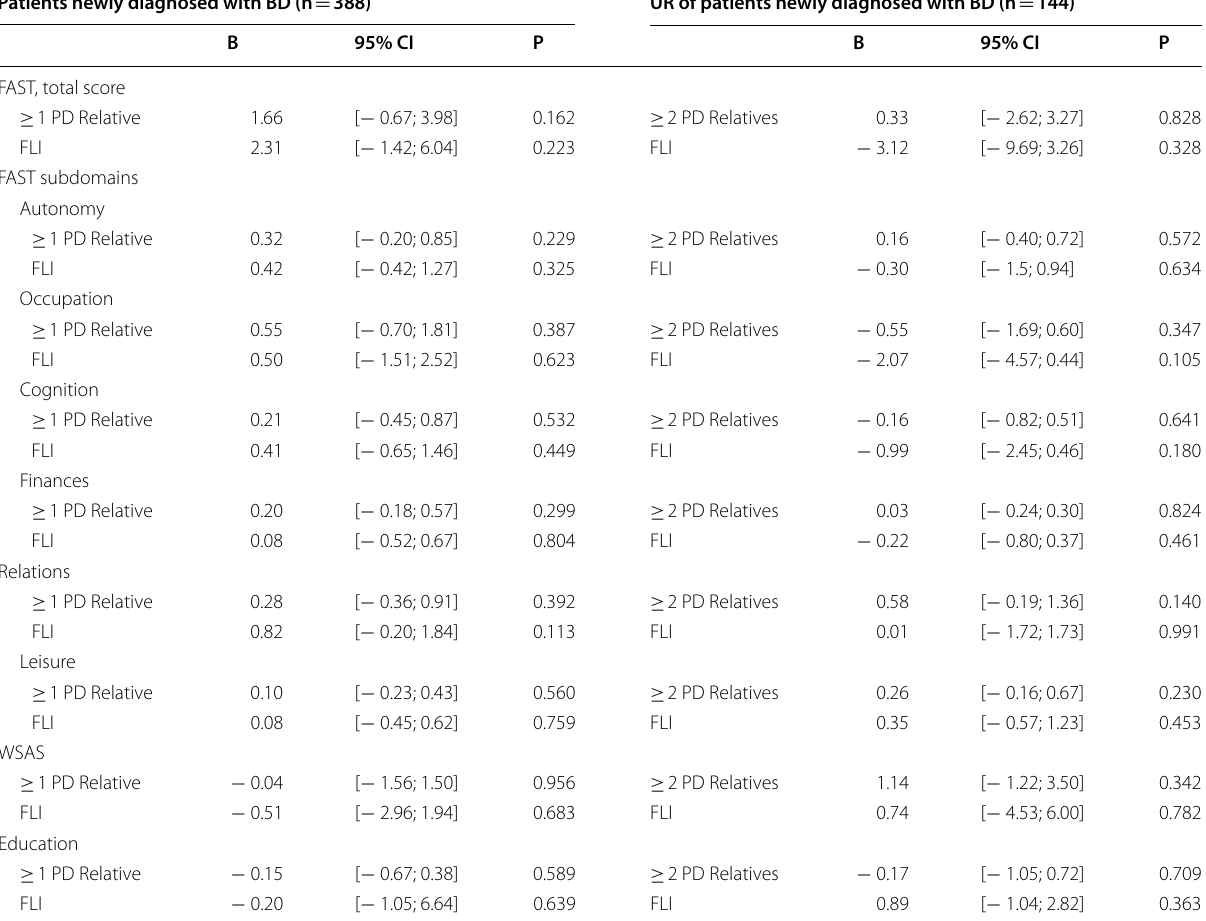
Table 3 Associations between familial load of psychiatric disorders (PD) and the outcomes (1) Functioning Assessment Short Test (FAST) in total scores and subdomains, (2) Work and Social Adjustment scale (WSAS) and (3) Years of education in patients newly diagnosed with bipolar disorder (BD) and their unaffected first-degree relatives